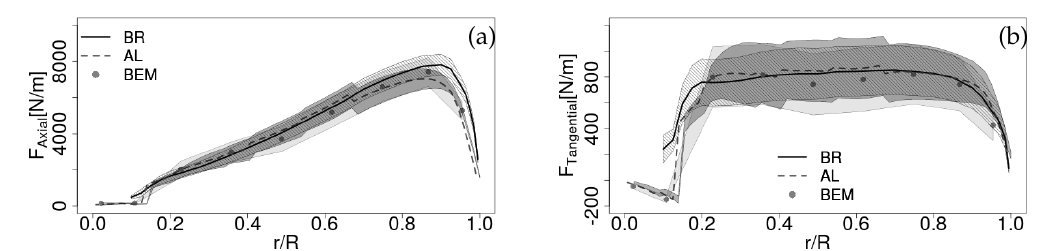
Figure 5. Radial distributions of ( a ) axial and ( b ) tangential forces per unit span. The shaded areas illustrate one standard deviation of the fluctuations.